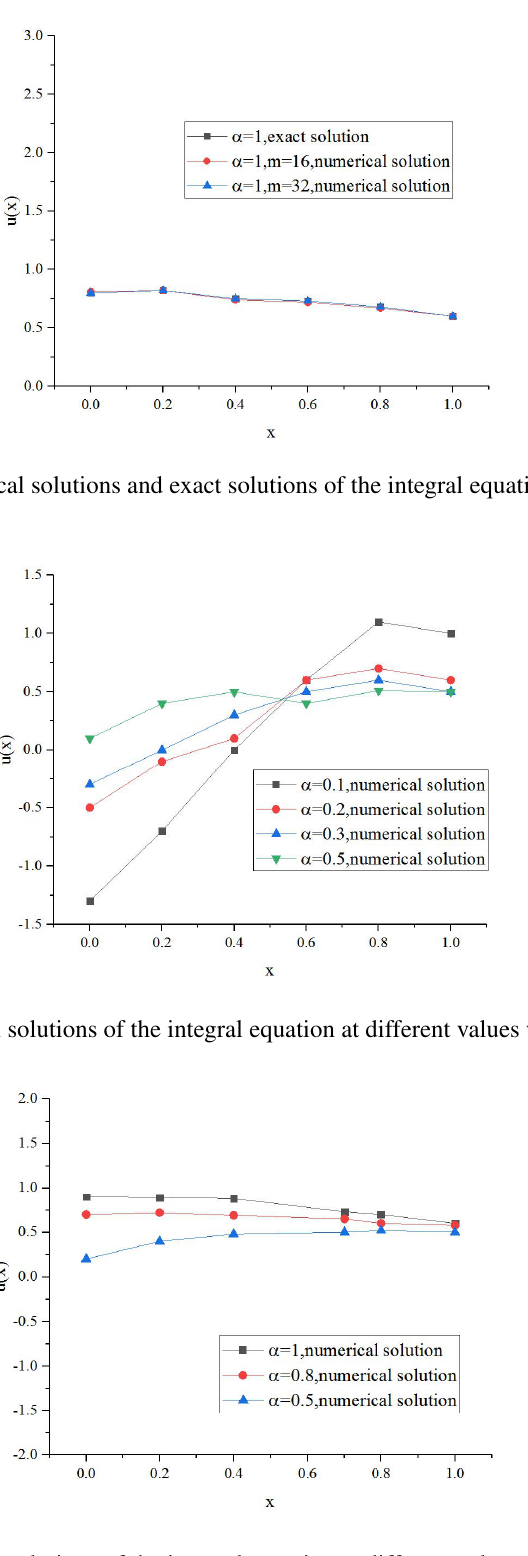
Fig. 3 Numerical solutions of the integral equation at different values when m =